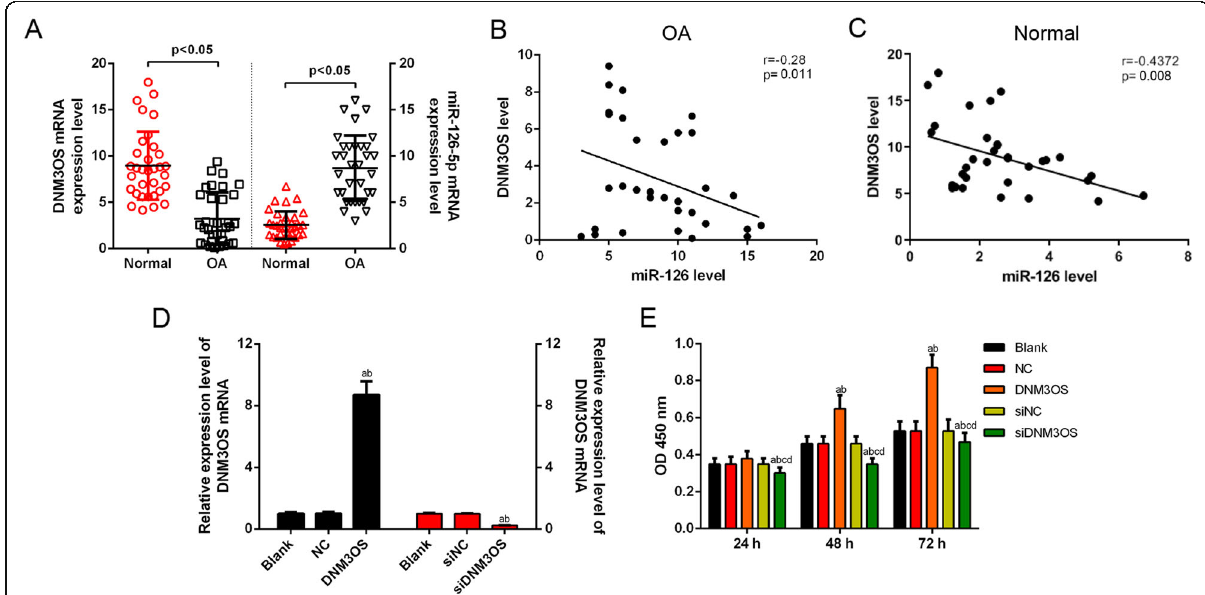
Fig. 1 DNM3OS was low-expressed in OA tissues, had negative correlation with miR-126 and promoted CHON-001 cells viability. ( a ) The expression of lncRNA DNM3OS in human OA tissues was significantly lower, while miR-126 was obviously higher than in normal tissues using RT-qPCR. ( b ) The expression of DNM3OS was negatively correlated with the miR-126 level in OA samples by Spearman ’ s correlation analysis. ( c ) The expression of DNM3OS was negatively correlated with the miR-126 level in normal samples by Spearman ’ s correlation analysis. ( d ) The transfection efficiency of DNM3OS was confirmed by RT-qPCR. ( e ) CHON-001 cells viability was improved or inhibited by DNM3OS or silencing DNM3OS by CCK-8 assay. a P < 0.05 vs. Blank, b P < 0.05 vs. NC, c P < 0.05 vs. DNM3OS, d P < 0.05 vs. siNC. siDNM3OS: small interfering dynamin 3 opposite strand; NC: negative control; OD: optical